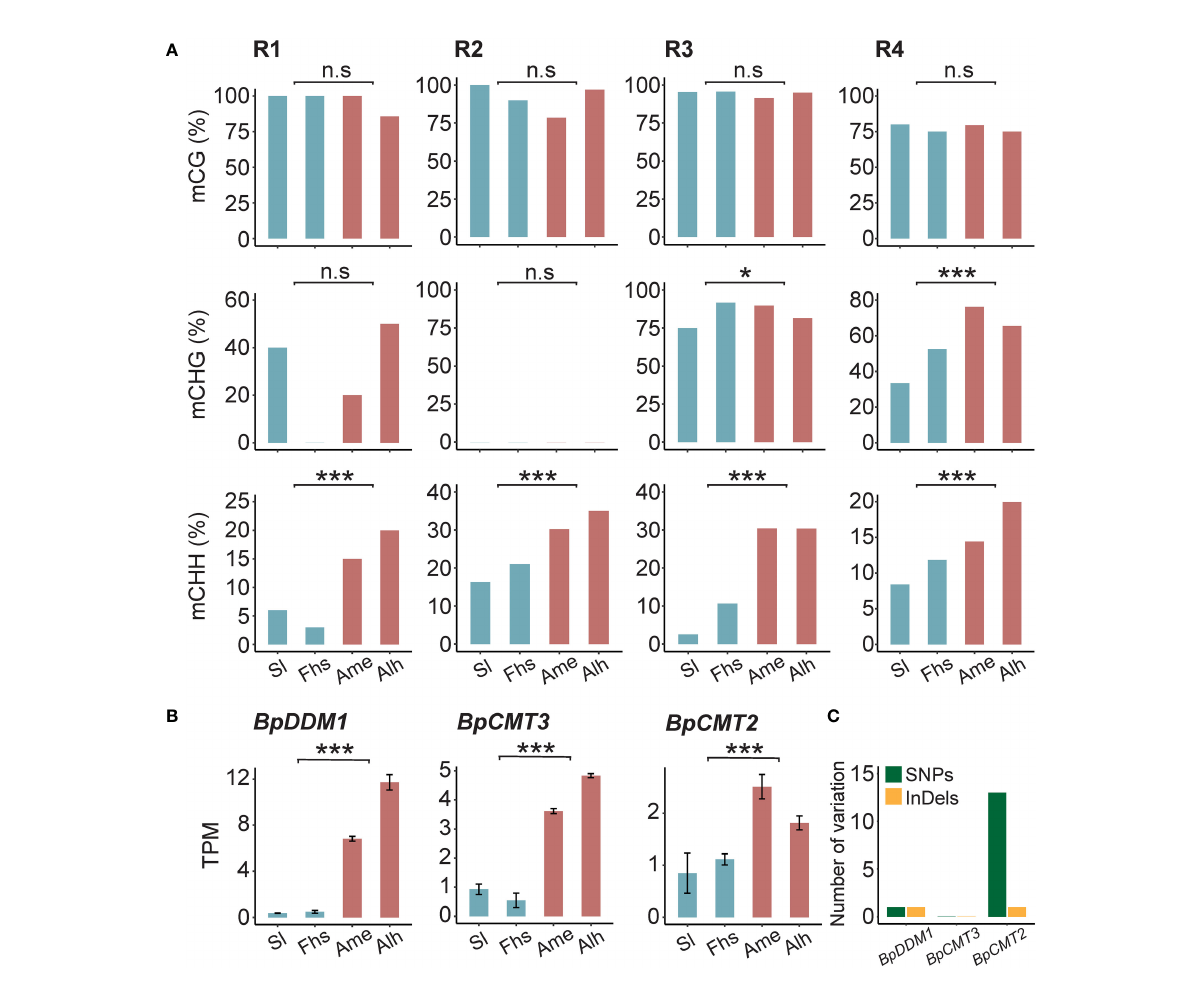
FIGURE 4 DNA methylation of BpNST1/2 and BpSND1 in different sequence background. (A) CG, CHG and CHH methylation levels in the R1-R3 ( BpNST1/ 2 ) and R4 ( BpSND1 ), and (B) transcript level of BpDDM1 , BpCMT3 and BpCMT2 in Sl, Fhs, Ame, and Alh. The p ≤ 0.05 is marked as ‘ * ’ , p ≤ 0.001 is marked as ‘ *** ’ and p > 0.05 is marked as ‘ n.s ’ . (C) Number of nonsynonymous mutations in the introns of BpCMT2 , BpCMT3 and BpDDM1 . Genetic variants were counted when variants at the locus were completely distinct from Ame and Alh to Sl and